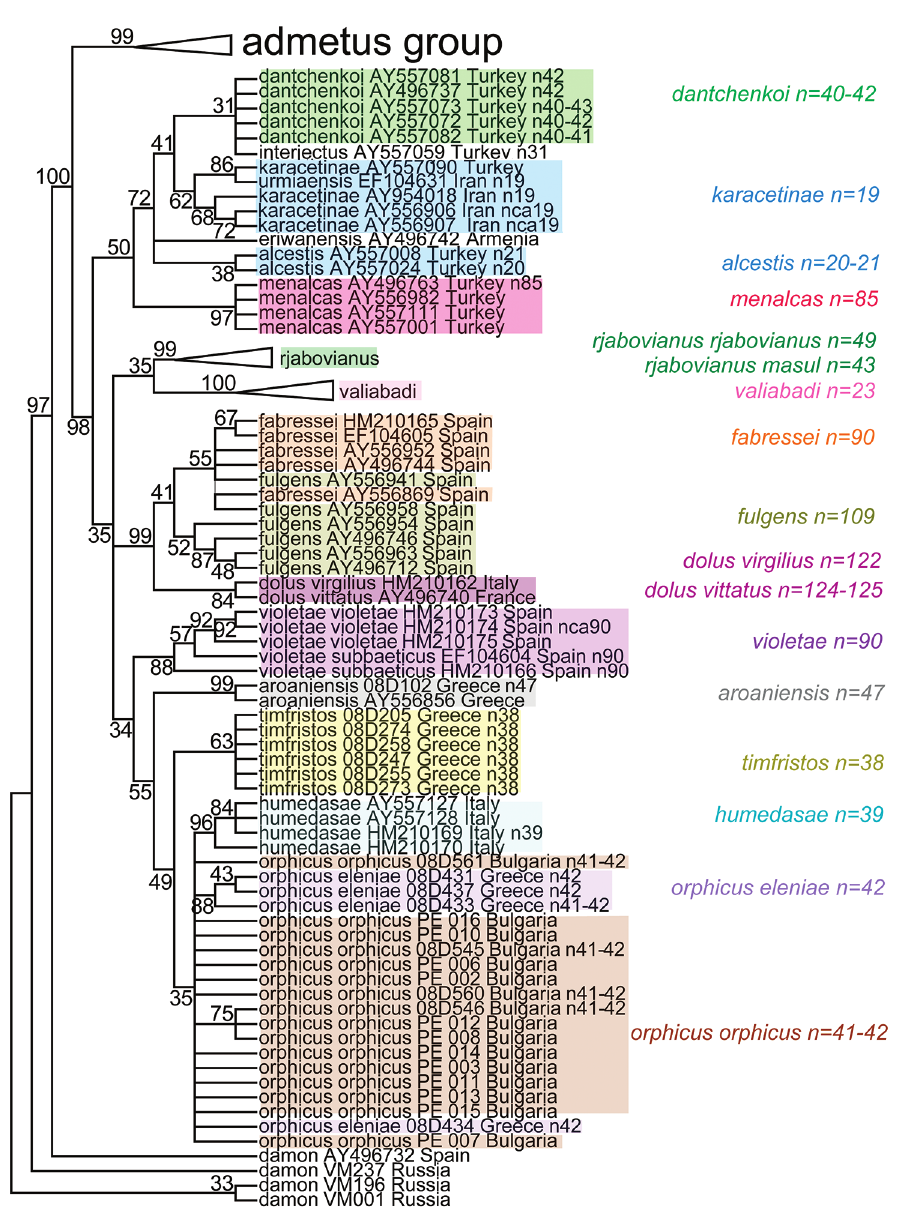
Figure 23. Fragment of the MP tree based on analysis of COI barcodes and focused on details of the P. dolus group. Polyommatus rjabovianus and P. valiabadi clades are not shown in details, for their composi- tion see Lukhtanov et al. (2015a). Numbers at nodes indicate bootstrap